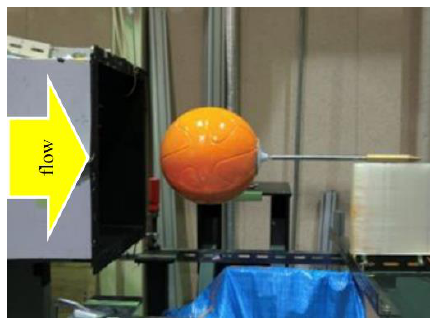
Figure 5. Oil film experiment (Krasava).